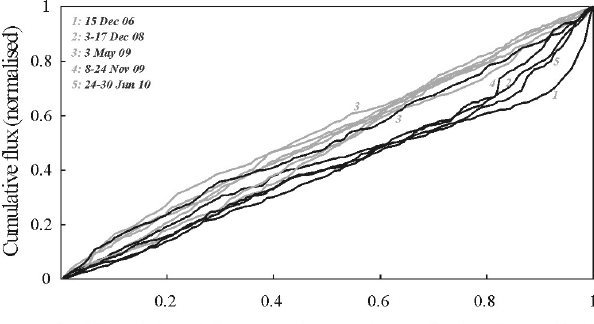
Fig. 5. Normalised cumulative CO 2 (black curve) and SO 2 (grey curve) flux trends for 5 periods of activity of Stromboli. The peri- ods over which the cumulative curves were drawn were all selected in order to start (t = 0) on the day after the previous explosive event and to end (t = 1) with one (or more) major explosions (numbers 1–5 denote the specific explosion(s) occurring at t = 1). Curves 5 for CO 2 and SO 2 are totally analogous, in the normalised form, to those shown in Fig. 4a, and have t = 0 on 13 March and t = 1 on 30 June. The time interval between 0 and 1 is thus the period over which a complete cycle of gas segregation-gas leakage can occur. The 5 sets of normalised cumulative curves show similar shapes which indicate a reproducible degassing regime prior to each major explosion and, hence, a common recurrent source mechanisms for these events. A less pronounced difference between SO 2 and CO 2 cumulative trends is observed for case 3, implying that while the in- volved source processes were probably the same, a smaller volume of CO 2 was accumulating/leaking prior to the to 3 May 2009